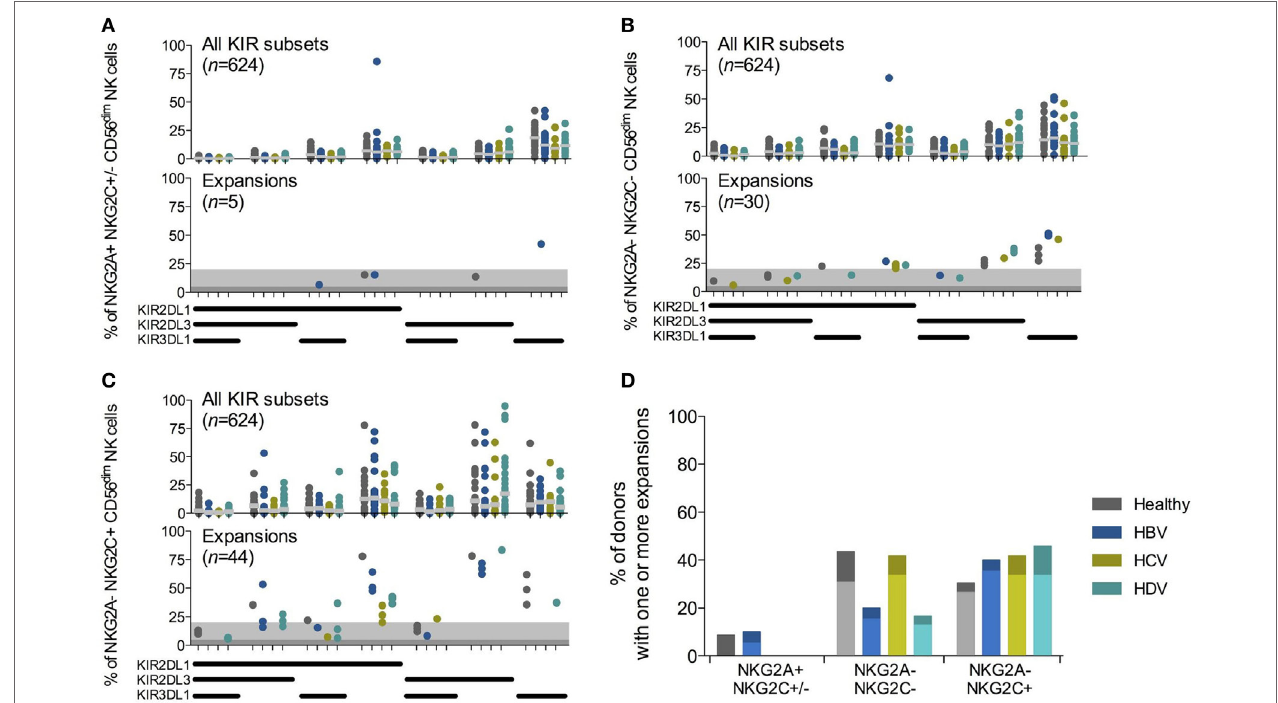
FigUre 2 | chronic viral hepatitis does not affect the frequency of cytomegalovirus (cMV)-driven natural killer (nK) cell expansions . (a–c) Killer-cell immunoglobulin-like receptor (KIR)-repertoire and adaptive-like NK cell expansions within NKG2A + NKG2C + / − (a) , NKG2A − NKG2C − (B) , and NKG2A − NKG2C + (c) CD56 dim NK cell populations in CMV seropositive individuals. Upper-row figures display all KIR subpopulations [ n = 23, 20, 12, and 24 for healthy individuals and hepatitis B virus (HBV), hepatitis C virus (HCV), and hepatitis delta virus (HDV) infected individuals, respectively]. Gray bar indicates median. Bottom-row figures display the identified expansions. The dark gray shading indicates a 5% and the light gray shading a 20% threshold for confirmation of expansions. (D) Percentage of CMV seropositive individuals that have at least one measured expansion within the CD56 dim NK cell population. Twenty percent threshold results depicted in light colored bars. Chi-squared test for all NK cell subsets: healthy, p < 0.02; HBV, p < 0.04; HCV, p < 0.08; HDV, p < 0.01; and between NKG2A − subsets: healthy, p = 1; HBV, p = 0.27; HCV, p = 1; HDV, p < 0.17. Five percent threshold results depicted as light and dark bars, Chi-squared test for all NK subsets: healthy, p < 0.03; HBV, p < 0.074; HCV, p < 0.03; HDV, p = 0.0004; and between NKG2A − subsets: healthy, p < 0.55; HBV, p < 0.3; HCV, p = 1; HDV, p <